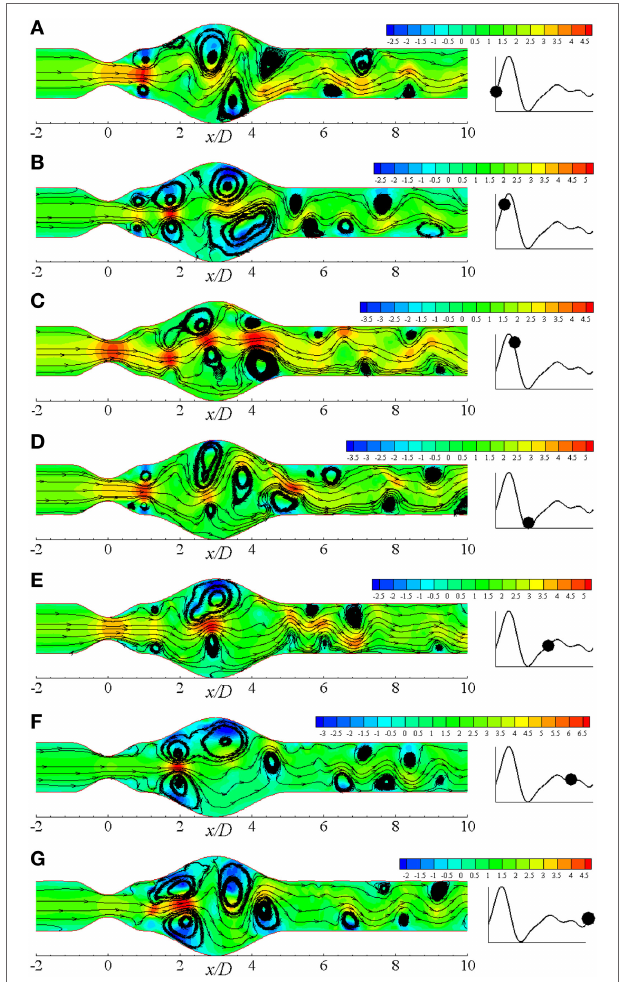
FIGURE 13 | Streamlines in different physiological phases (A) t / T = 9.0, (B) t / T = 9.1, (C) t / T = 9.2, (D) t / T = 9.3, (E) t / T = 9.5, (F) t / T = 9.7, (G) t / T = 9.10 when aneurysm = 100% dilated and stenosis = 60% constricted for Re = 750 where the amplitude of wall oscillation, A = 3 (cid:2) 10 (cid:0) 4